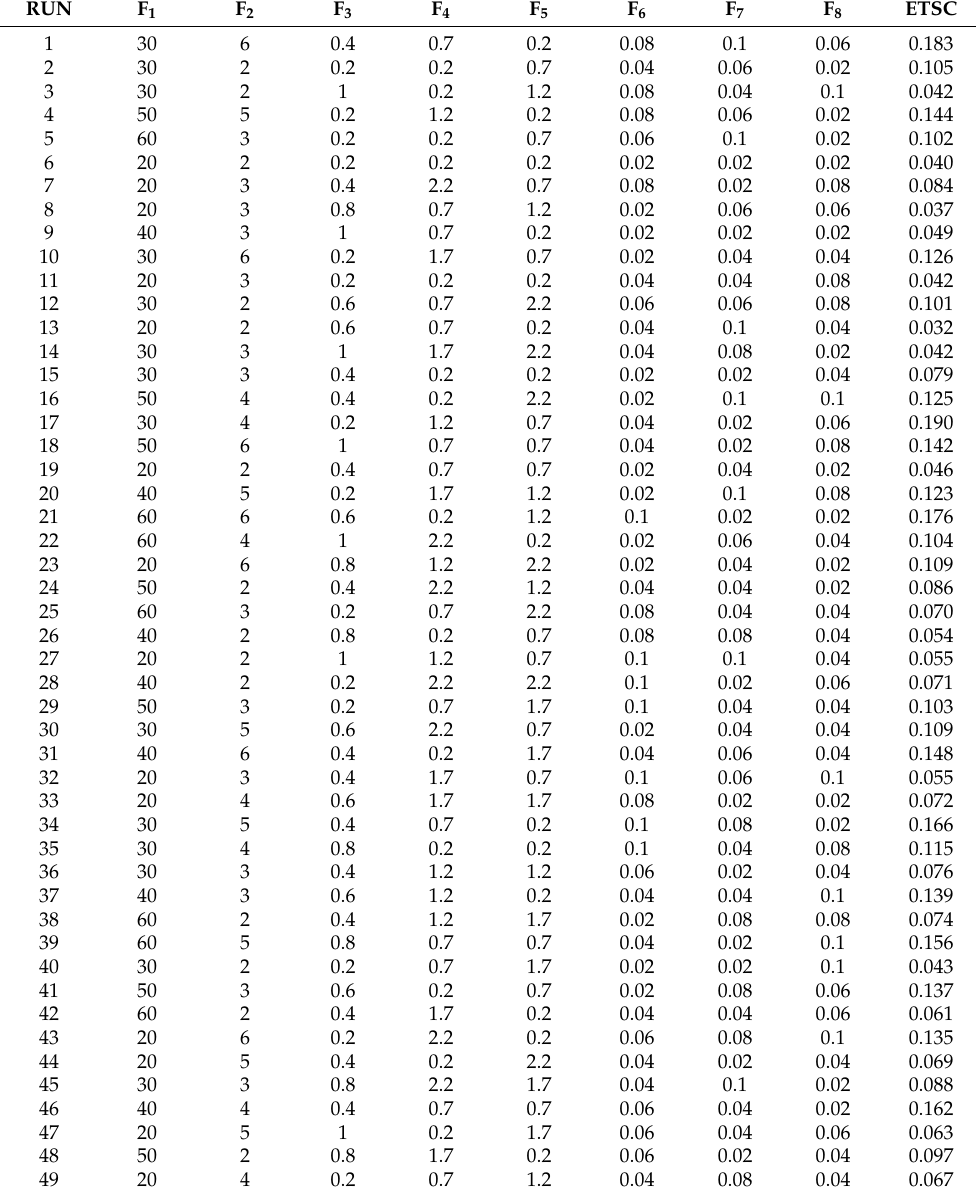
Table 2. The designs and results of the orthogonal experiments for medium composition